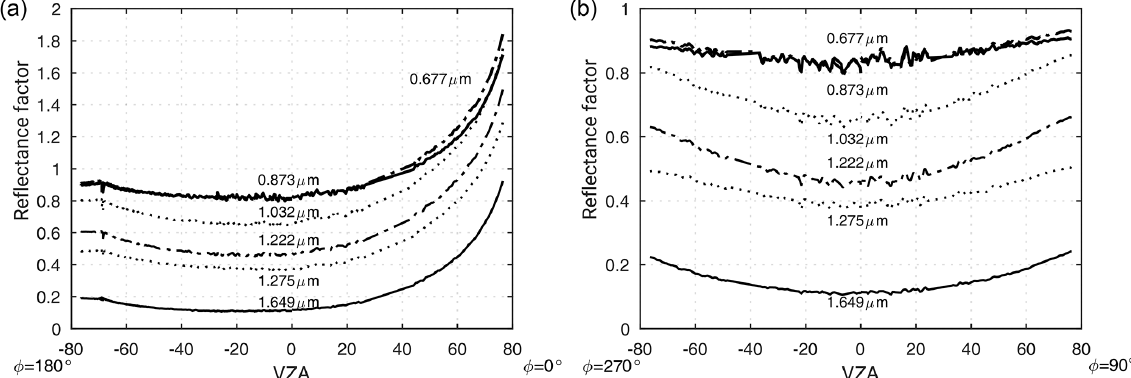
Figure 3. Angular distribution of the reflectance factor in the snow–atmosphere system, derived from measurements by CAR at 647m flight altitude and six wavelengths of 0.677, 0.873, 1.032, 1.222, 1.275, and 1.649µm on 7 April 2008 at Elson Lagoon (71.3 ◦ N, 156.4 ◦ W). (a) The principal plane ( ϕ = 0 and 180 ◦ ) and (b) cross plane ( ϕ = 90 and 270 ◦